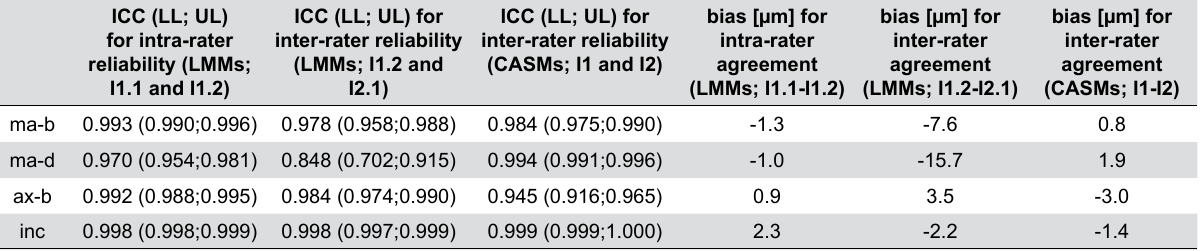
Definitions: ICC= intraclass correlation coefficient; LL= lower limit; UL= upper limit; LMMs= light microscopy measurements; CASMs= computer-assisted measurements; I1.1 and I1.2= first and second measurements of the first investigator (LMM); I2.1= measurement of the second investigator (LMM); I1 and I2= measurements of the first and second investigators (CASM); bias= mean of differences between measurements at specific measurement points. Measurement points: marginal-buccal (ma-b), marginal-distal (ma-d), axial-buccal (ax-b), incisal (inc).